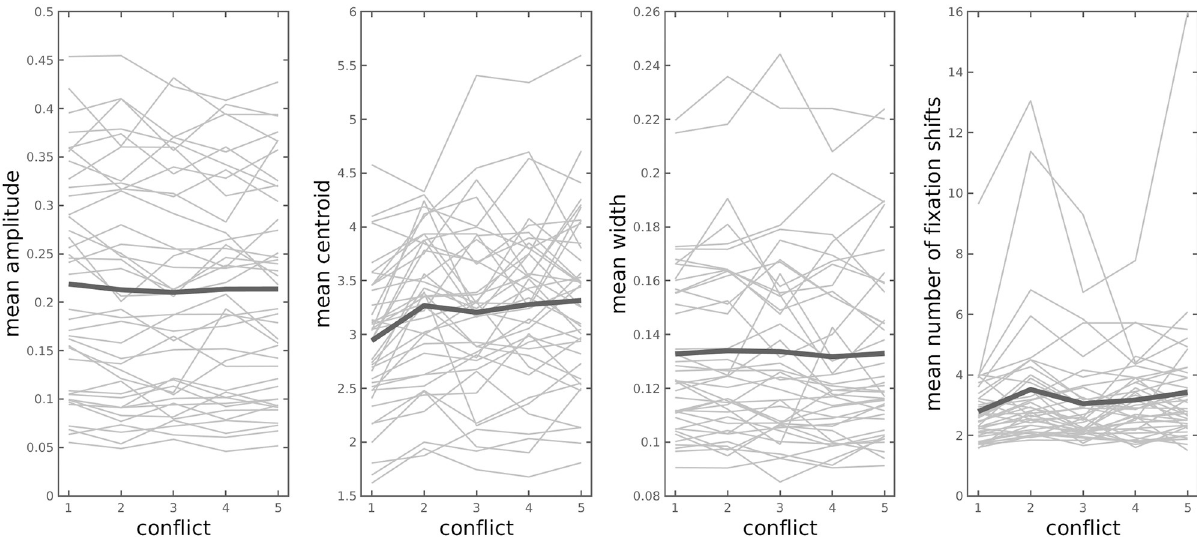
Fig 4. Mean amplitude, centroid and width of the Gaussian-modelled grip force response and mean number of fixation shifts (from SS to LL, and vice versa) for trials of a given (binned) response conflict for each participant. Thick lines depict the mean values across participants. Conflict is defined from 1 (low conflict) to 5 (high conflict), with a probability of .5 of choosing the LL reward as maximum conflict. Amplitude has been normalised to MVC (maximal voluntary contraction). Centroid and width are reported in seconds.